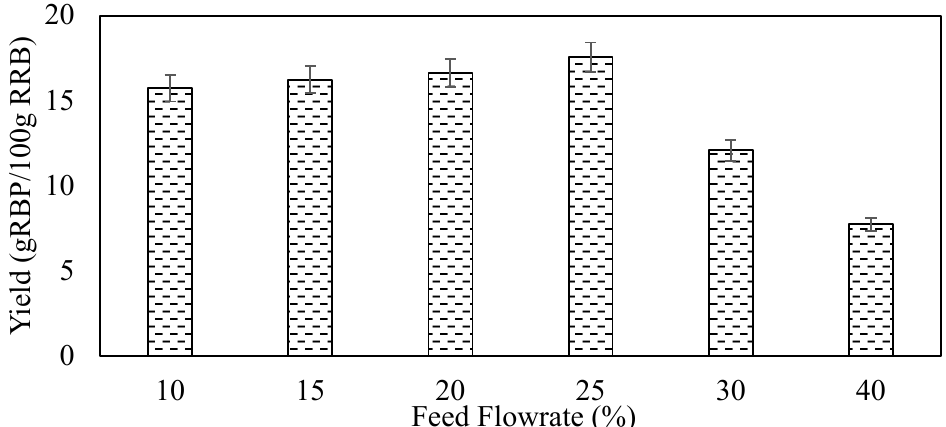
Figure 3. Effect of feed flowrate on the spray-drying process of the Rice Bran Protein (RBP) powder yield at a constant inlet temperature of 160 °C and a 388 L/h air flowrate.